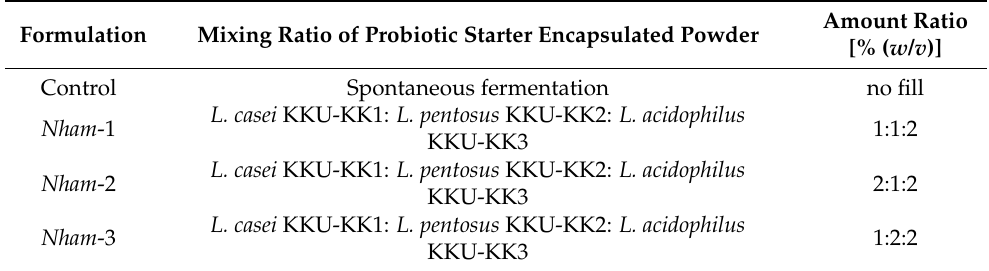
Table 1. Formulation ratios of the probiotic starter encapsulation, consisting of L. casei KKU-KK1, L. pentosus KKU-KK2, and L. acidophilus KKU-KK3, for the Nham fermentation process.